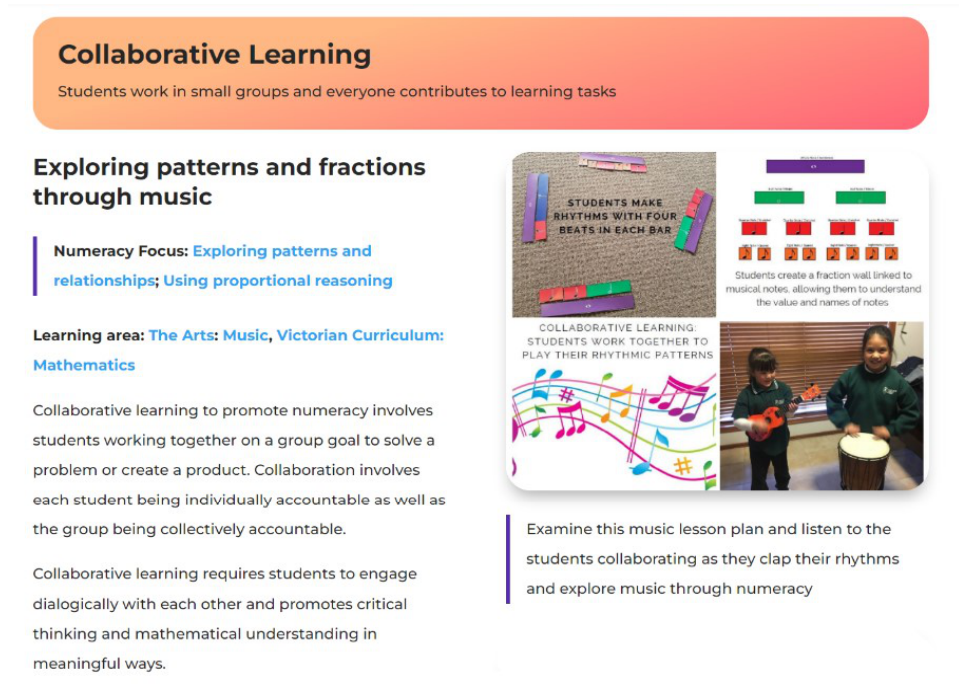
The High Impact Teaching Strategy of Collaborative Learning Illustrating Numeracy Within a Music